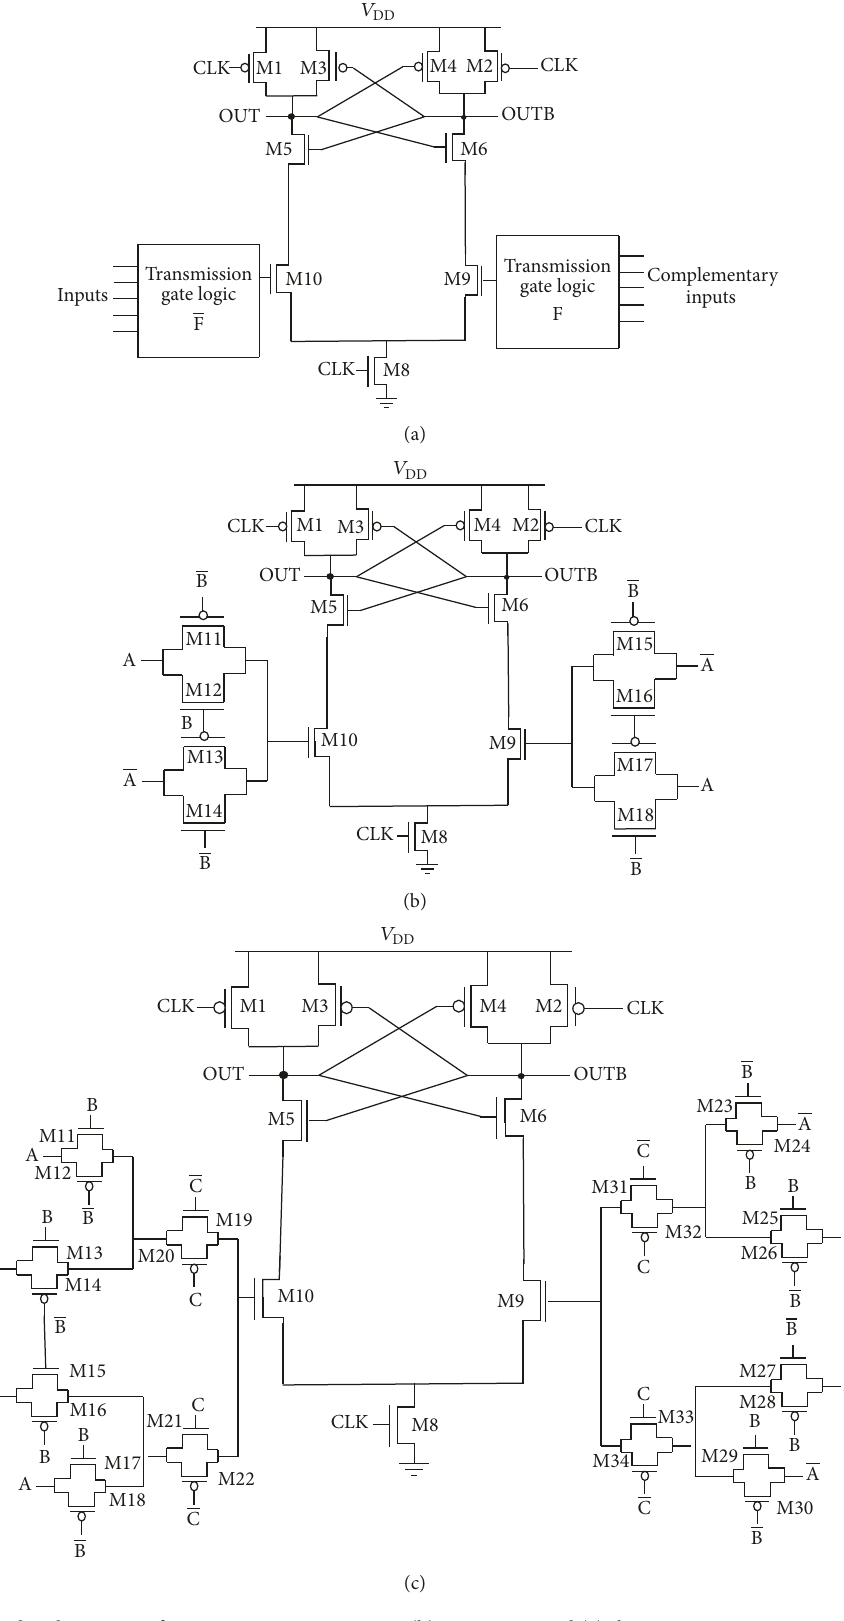
Figure 3: (a) Proposed architecture-1 for Dy-TG-DCVSL circuits. (b) Two-input and (c) three-input Dy-TG-DCVSL XOR-XNOR